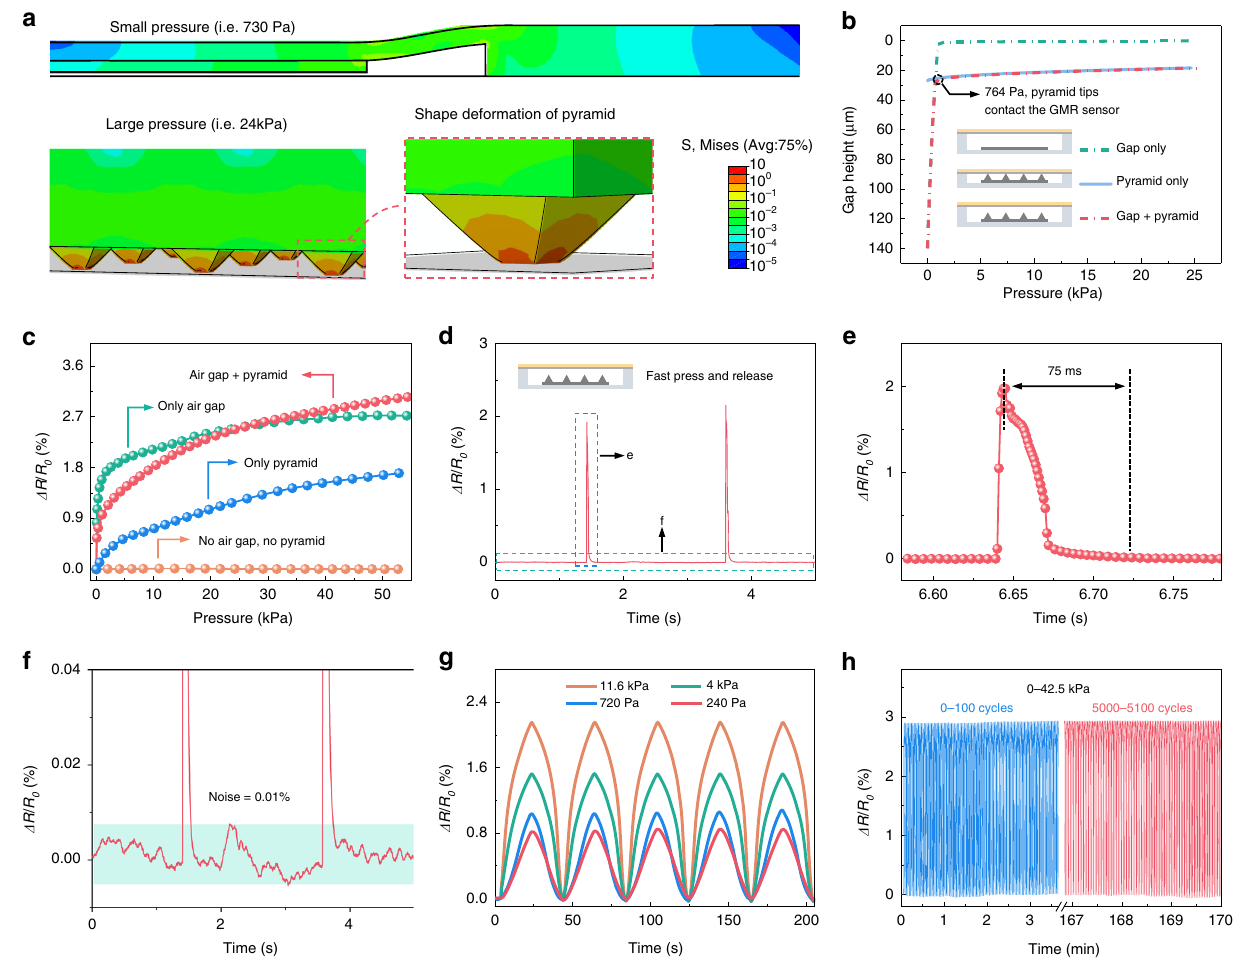
Fig. 3 Impact of the m-MEMS structure on the pressure sensing performance. a Finite element mechanical simulations of the shape deformation and stress distribution of a compliant m-MEMS platform under high and low applied pressure. b The simulated change of the air gap height as a function of the applied pressure for the case of the m-MEMS platform possessing pyramids only, air gap only as well as a combination of air gap and pyramids. c The experimentally measured change of the electrical resistance of the compliant m-MEMS platform as well as the devices with pyramids only, with air gap only, and without air gap and pyramids, versus the applied pressure. d The experimentally measured change of the resistance of the compliant m-MEMS platform under a fast pressure stimulus. e The close-up of the area indicated with a dash square in d . f The close-up of the baseline in panel d , highlighting the excellent signal-to-noise ratio of over 100. g The experimentally measured change of the electrical resistance of the compliant m-MEMS platform during the press-release cycles. The device is exposed to a pressure of different magnitude of 240 Pa, 720 Pa, 4 kPa, and 11.6 kPa. h Durability test of the compliant m-MEMS platform by applying more than 5000 press-release cycles without signs of fatigue. Maximum pressure is 42.5